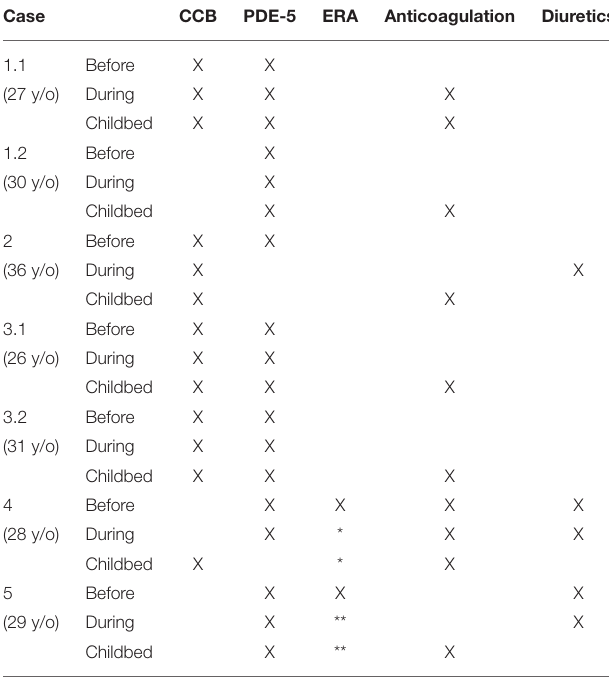
TABLE 3 | PAH targeted medication around pregnancy.